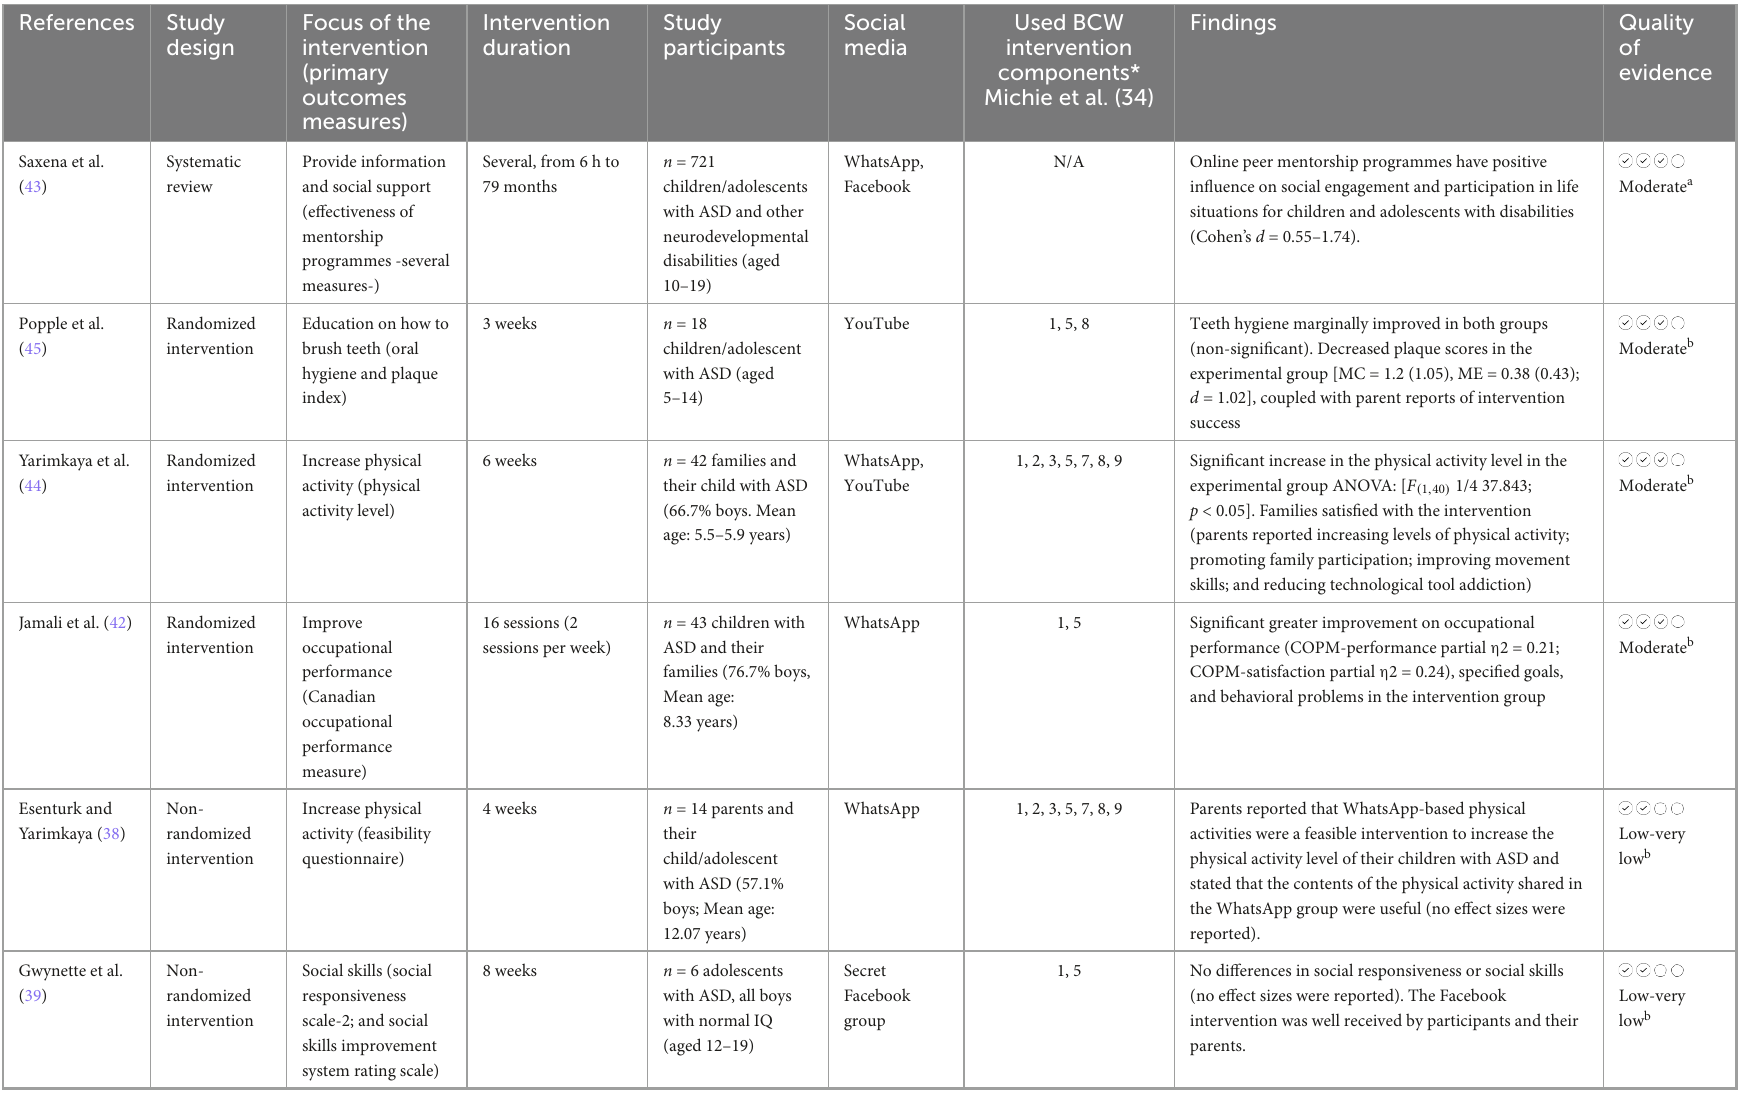
TABLE 1 Summary of the studies included in this review ( n =